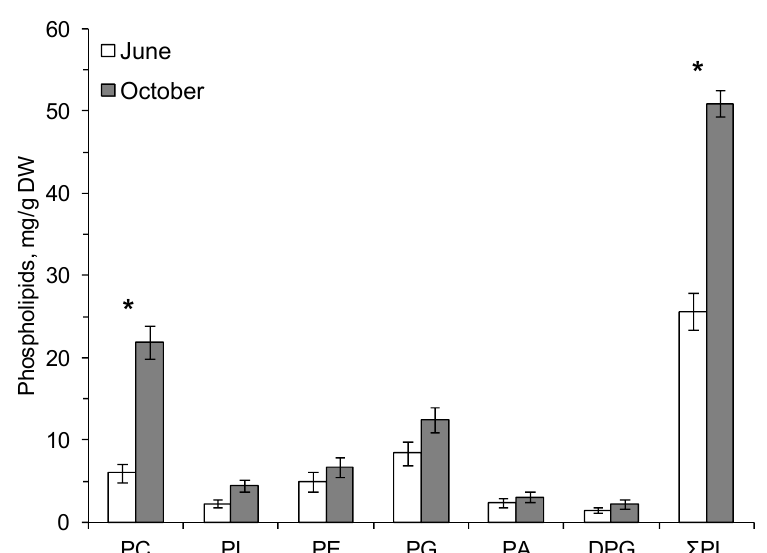
Figure 2. The contents (mg / g dry weight, standard error) of total phospholipids ( Σ PL), phosphatidylcholine—PC, phosphatidylinositol—PI, phosphatidylethanolamine—PE, phosphatidylglycerol—PG, phosphatidic acid—PA and diphosphatidylglycerol—DPG in the leaves of Bromopsis inermis on 16.06.2014 (June) and 3.10.2014 (October). *—Significant di ff erences according to Student’s t -test.